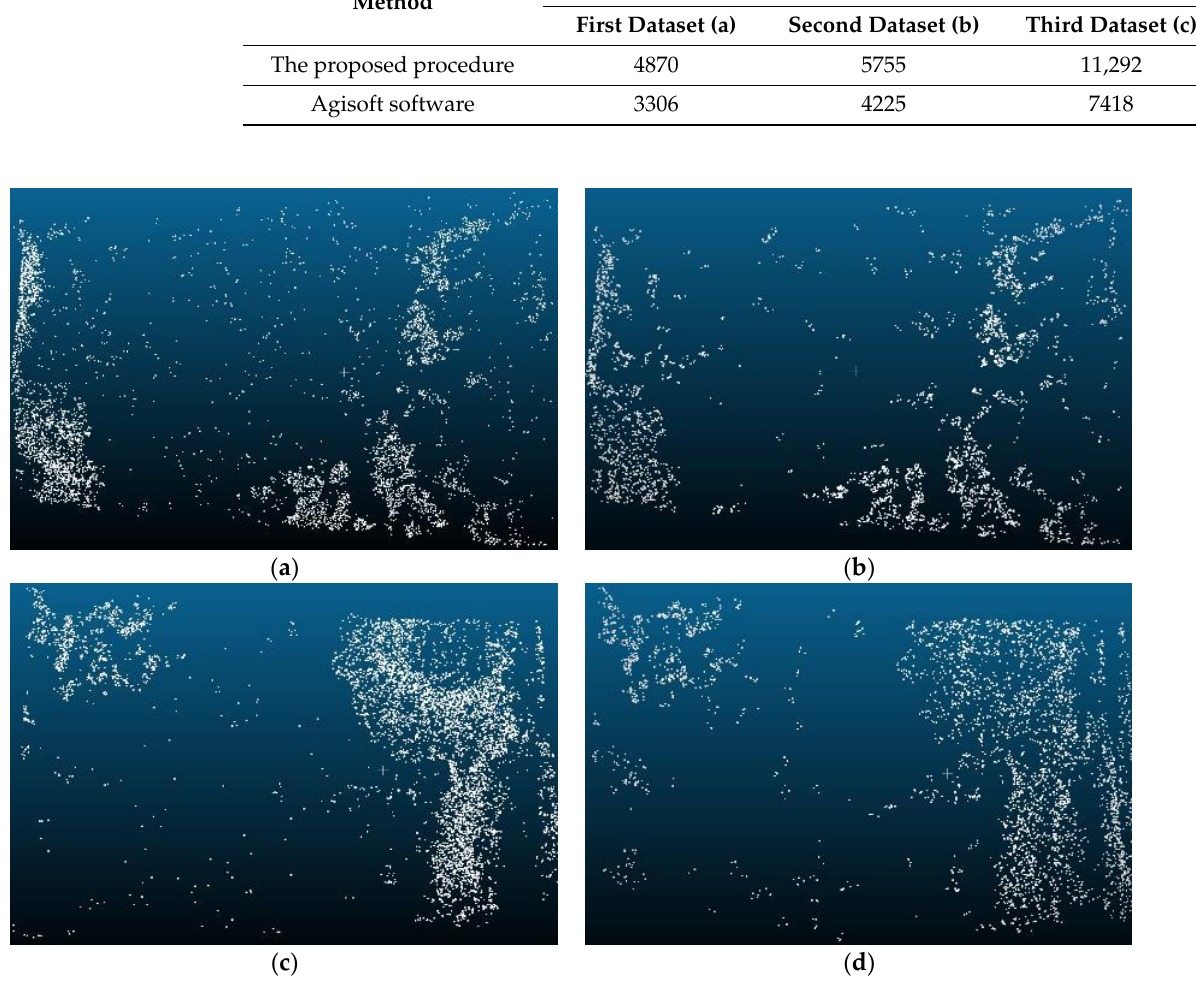
Table 6. The number of inliers.